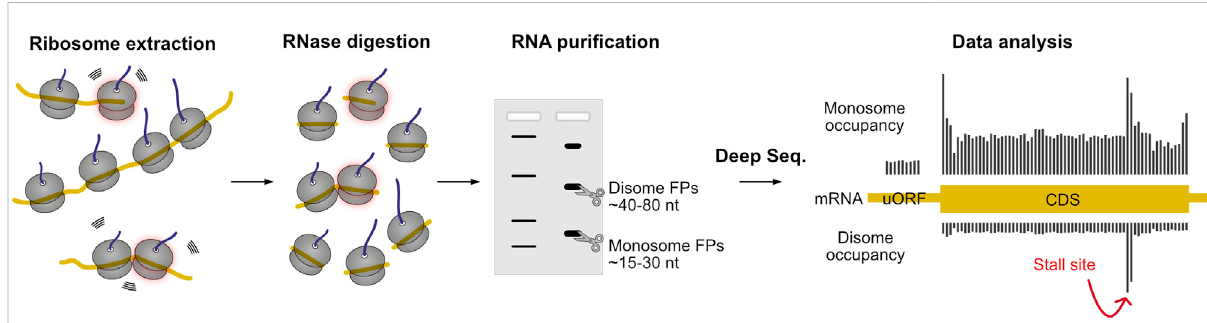
FIGURE 7 Ribosome pro fi lingallows large-scale monitoring oftranslationdynamics.First,ribosome nascent-chain complexes areextractedfromcells or tissues, and then they are treated with RNase. Translating ribosomes protect small pieces of mRNA from digestion, resulting in ribosome footprints (FPs) that re fl ect the position of the ribosome on the mRNA. The FPs of monosomes or stacked ribosomes are then isolated by electrophoresis and analyzed by deep sequencing technology. The abundance of monosome FPs serves as a quantitative measure of translation (ribosome association) at codon resolution. Disome footprints occur upon ribosomal stalling with subsequent ribosome collision, and are indicative of hard to decode sequences. The protocol can also be adapted to identify short footprints resulting from ribosomal stalling in the 3 ′ end of truncated